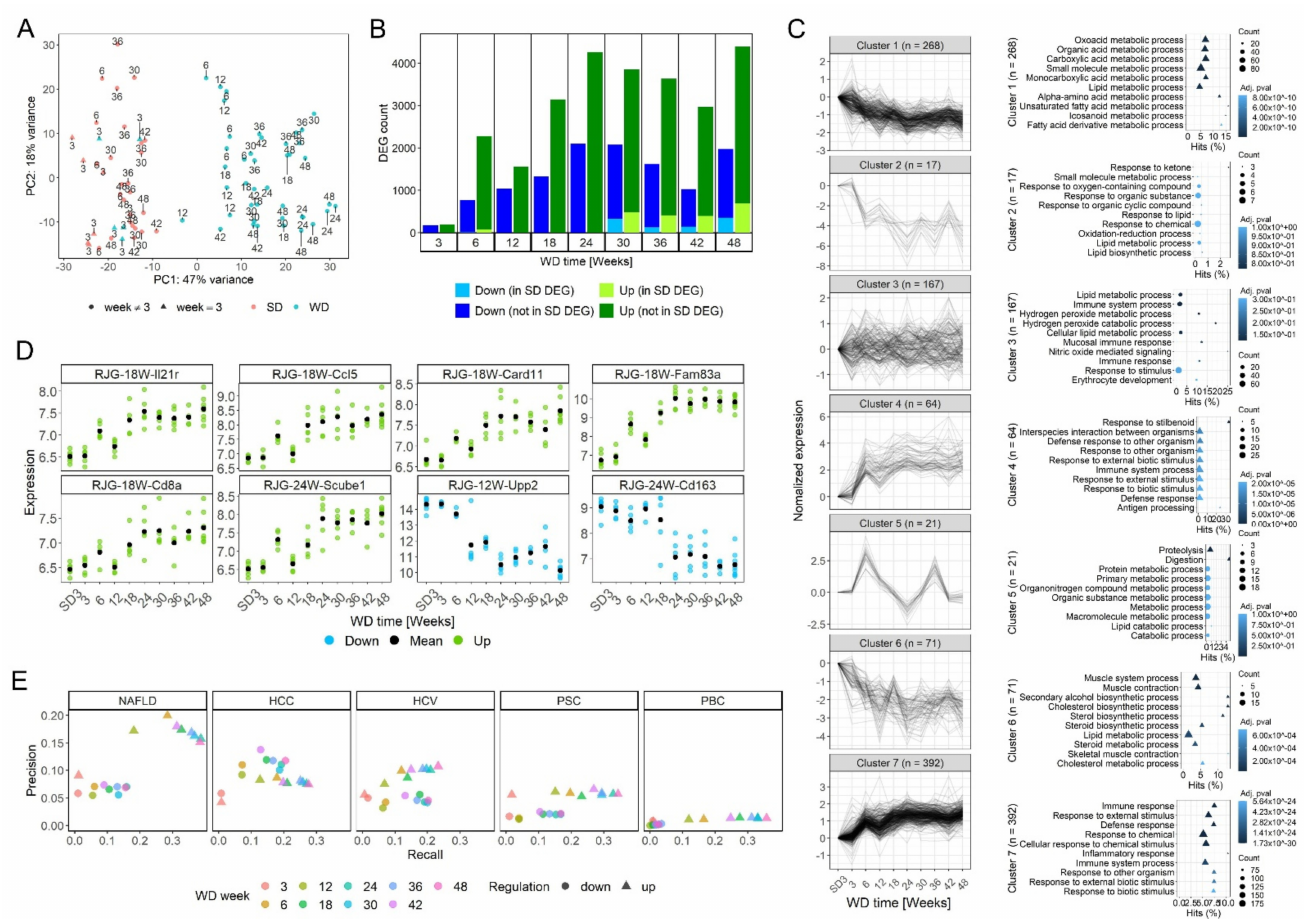
Figure 2. Time-resolved RNA seq analysis. ( A ) Principal component (PC) analysis of all WD- (blue) and SD- (red) fed mice. Numbers in the panel indicate weeks on the WD or SD feeding. ( B ) Numbers of differentially expressed genes (DEGs) compared to SD week 3; adj p < 0.01; abs(log 2 fold change) ≥ log 2 (1.5). The light blue and light green color indicate DEGs that are differentially expressed in the WD and SD for the time periods with available SD controls (weeks 3, 6, 30, 36, 42, 48). ( C ) Left: k-means clustering of the 1000 genes with highest variability. In parentheses: numbers of genes making up the individual clusters. Right: 10 most enriched gene ontology (GO)-groups of each cluster. Count: number of DEGs in each GO-group and fdr-adjusted p -value; only GO-groups with at least three DEGs were included. ( D ) Examples of rest-and-jump genes (RJG). ( E ) Similarity of DEGs for the individual WD feeding periods compared to human NAFLD, hepatocellular carcinoma (HCC), hepatitis C virus infected liver tissue (HCV), primary sclerosing cholangitis (PSC), and primary biliary cholangitis (PBC) for up ( ∆ ) and down ( • ) regulated genes. (See also gene lists in Datasheet